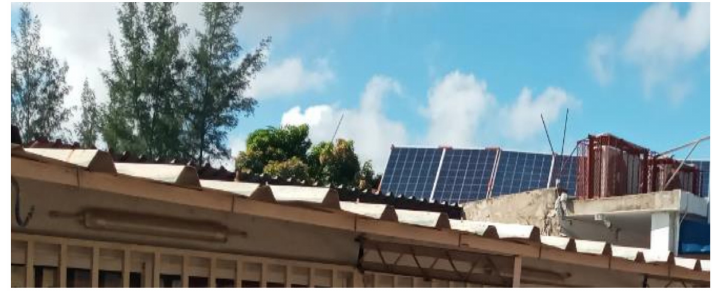
Figure 4. Solar PV system in Matola N2